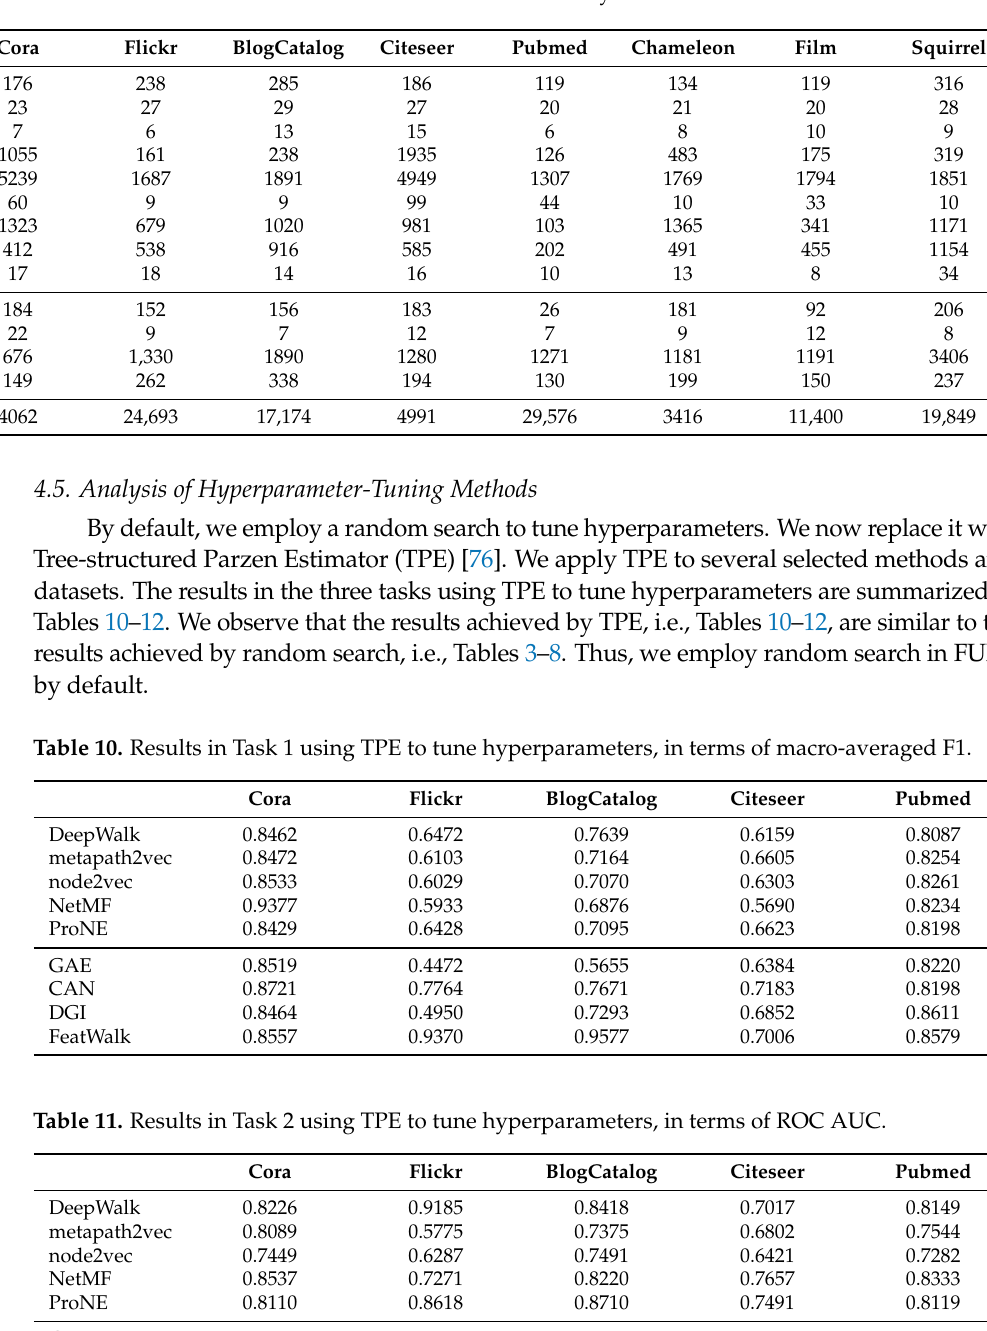
Table 9. Total rounds of hyperparameter tuning of each method on each dataset. The results are obtained under the constraint of a constant time shared by all methods.